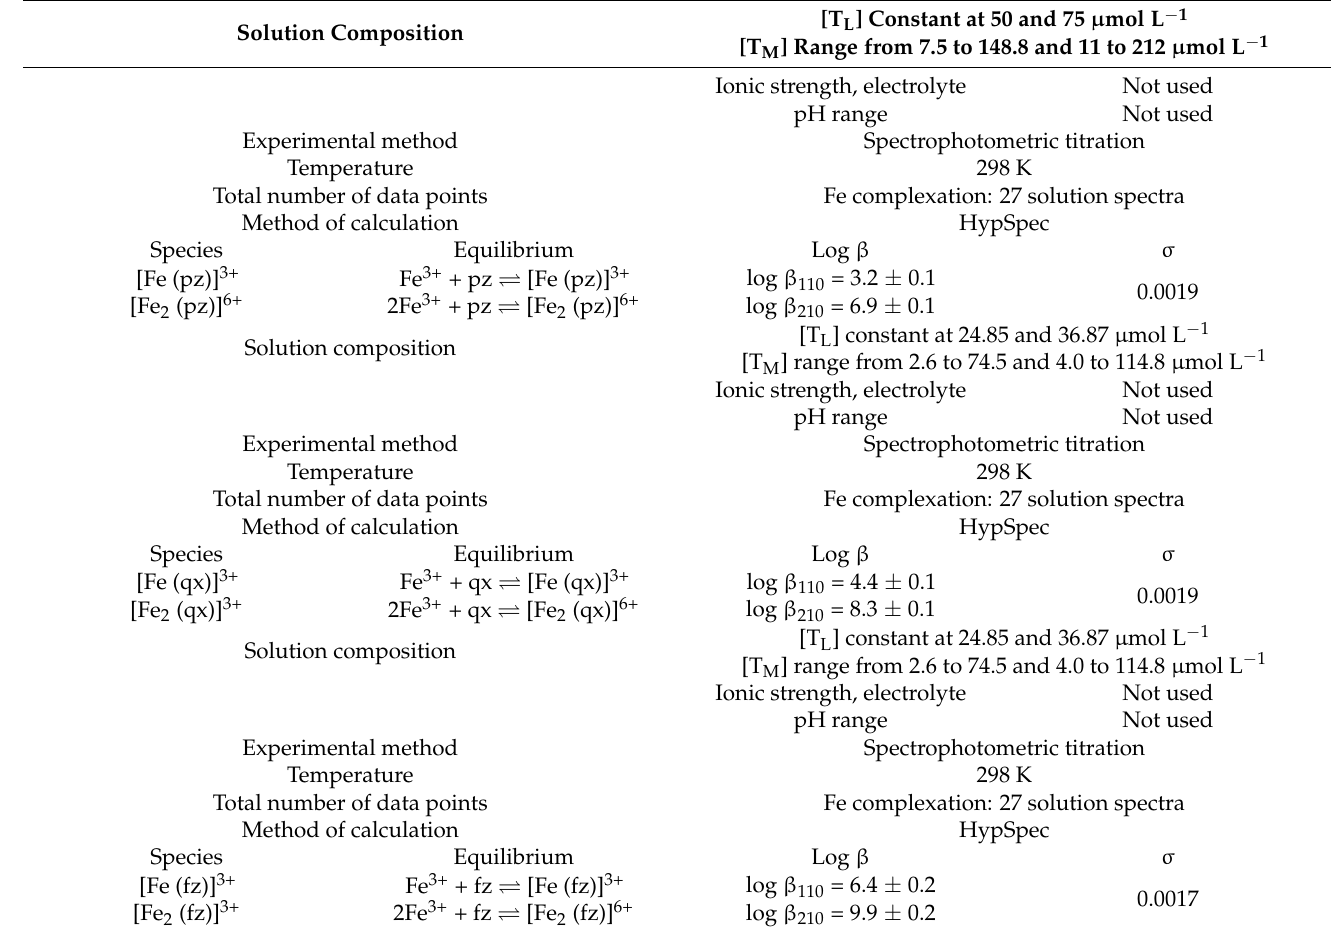
Table 1. Summary of experimental parameters for the systems Fe 3+ with pyrazine (pz), quinoxaline (qx) and phenazine (fz) in